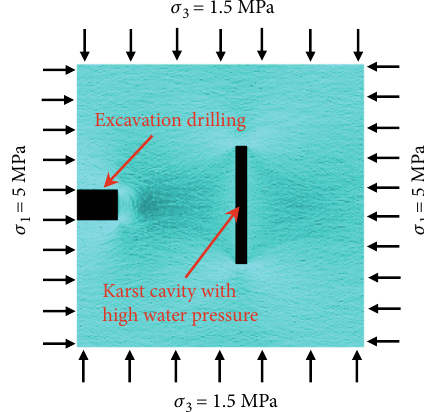
Figure 3: Numerical simulation